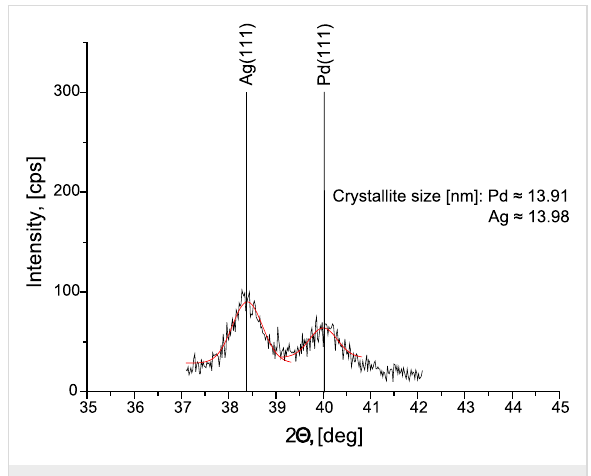
Figure 7: XRD results (a) obtained by using Cu K α radiation in θ –2 θ mode on Ag(15 nm)/Pd(15 nm) after heat treatment at 150 °C for 4 h. The grain sizes were determined from the half line width broadening using the Scherrer formula.